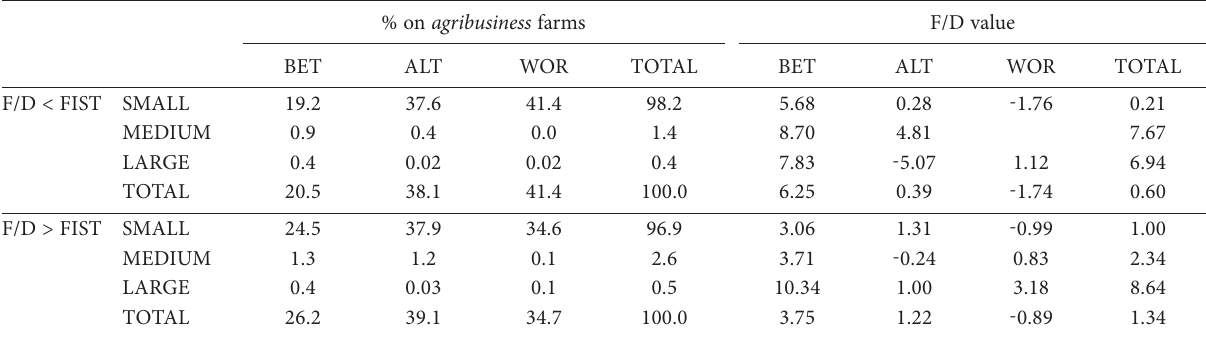
Table 8. Percentage distribution of agribusiness farms by financial result groups, size class and by groups of TFs, with relative value of the F/D